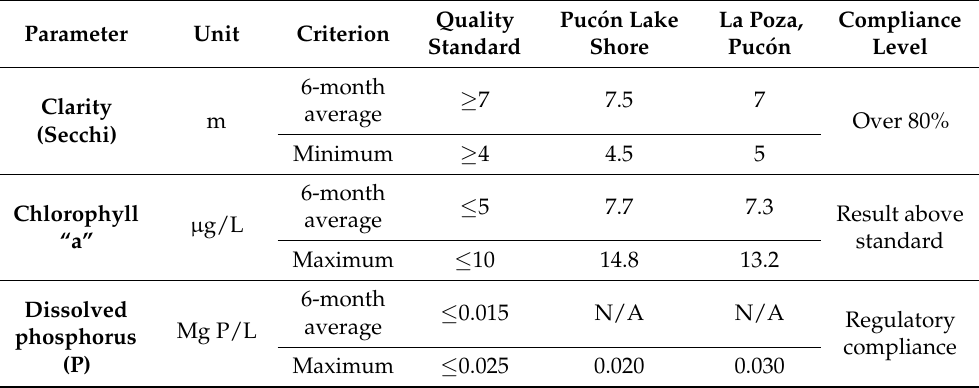
Table 4. Levels of chlorophyll pollution, Lake Villarrica. Fuente: Plan Maestro de Desarrollo Territorial Sustentable Puc ó n,